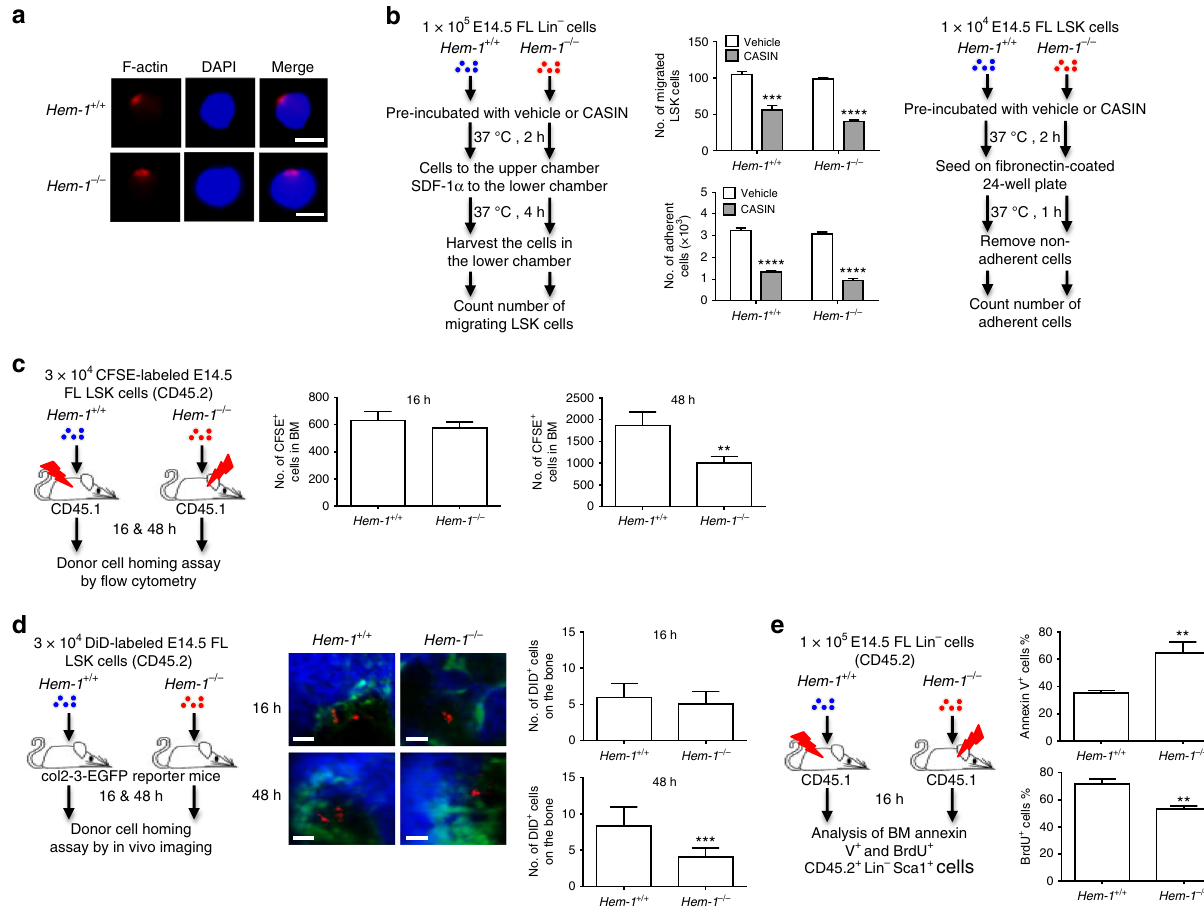
Fig. 3 Hem-1 − / − hematopoietic stem and progenitor cells migrate and adhere normally. a Actin polymerization and capping are normal in E14.5 Hem-1 − / − FL LSK cells in response to SDF-1 α stimulation. Representative microscopic images are shown (scale bar = 10 μ m). b Migration towards SDF-1 α and adherence to fi bronectin were not different in E14.5 Hem-1 − / − FL Lin − hematopoietic cells compared to Hem-1 + / + FL Lin − cells, but they could be suppressed by inhibition of CDC42 with CASIN, a speci fi c CDC42 inhibitor ( n = 3, *** p < 0.001, **** p < 0.001, two-way ANOVA). c Homing of CFSE- labeled E14.5 Hem-1 − / − FL LSK hematopoietic cells to radiation-ablated adult marrow as measured by fl ow cytometry was not different from littermate E14.5 Hem-1 + / + FL LSK cells at 16 h after injection. However, there were decreased CSFE-labeled E14.5 Hem-1 − / − FL LSK cells present in the marrow at 48 h after injection ( n = 5, ** p < 0.01, Student ’ s t test). d Homing of DiD-labeled E14.5 Hem-1 − / − FL LSK cells to the osteoblastic niche of col2-3-EGFO reporter mice was normal compared to littermate Hem-1 + / + equivalent cells. However, after 48 h, there were decreased CSFE-labeled E14.5 Hem-1 − / − FL LSK cells present in the osteoblastic niche ( n = 266 – 418 cells in three distinct mice, scale bar = 50 μ m, *** p < 0.001, Student ’ s t test). e There were fewer E14.5 Hem-1 − / − FL Lin − hematopoietic cells cycling as measured by BrDU incorporation and more undergoing apoptosis as measured by Annexin V expression after transplantation and migration to a radiation-ablated adult marrow than comparable littermate Hem-1 + / + cells ( n = 5, ** p < 0.01, Student ’ s t